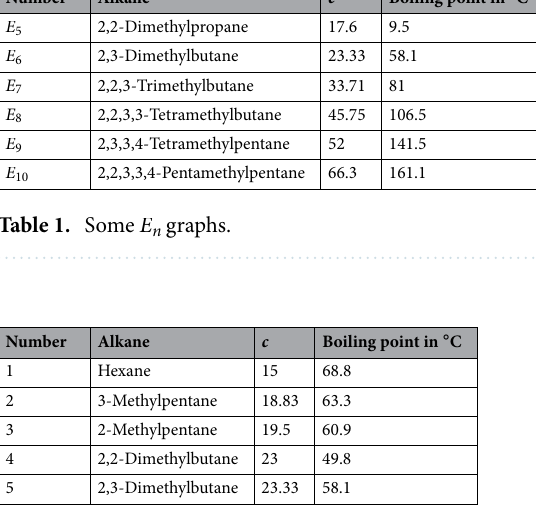
Table 2. Data for 5 alkanes with 6 carbon